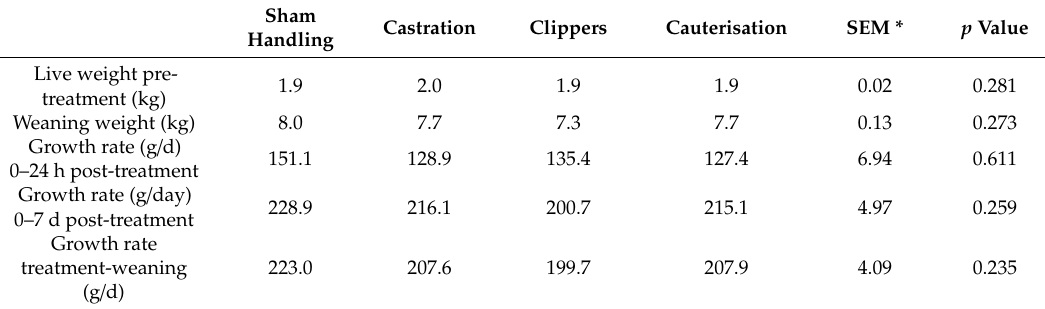
Table 5. E ff ect of treatment on growth performance of